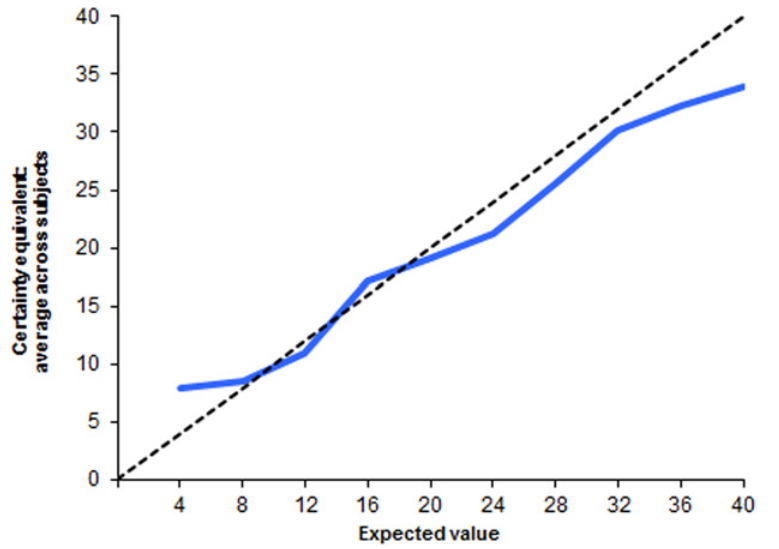
Fig 4. Average certainty equivalent (selling price) by lottery.